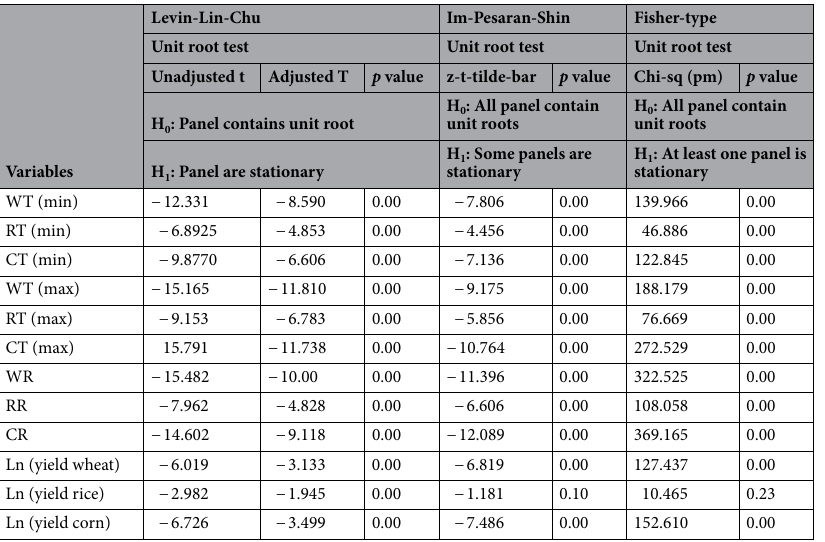
Table 3. Various tests to check the stationarity in the data. WT, RT, and CT represent the Wheat temperature, Rice temperature, and Corn temperature, respectively. WR, RR, and CR represent the Wheat rainfall, Rice rainfall, and Corn rainfall, respectively.